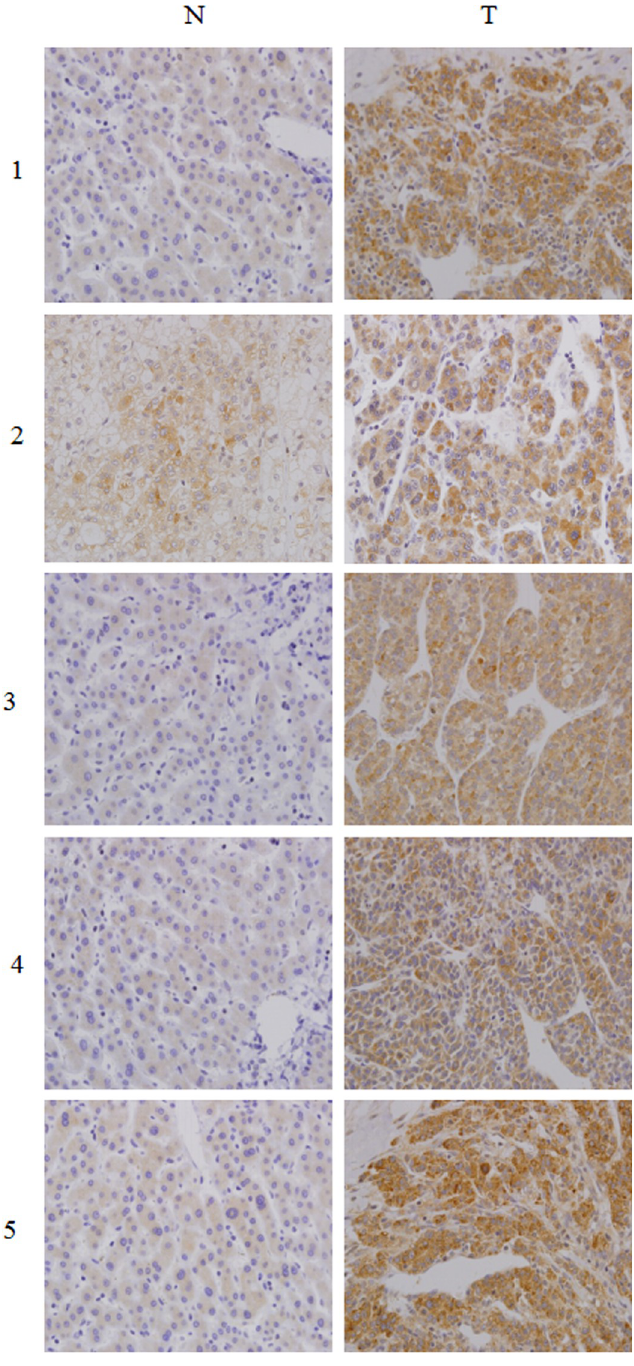
Fig 2. Numb expression level up-regulated in the primary HCC tissues compared with the paired adjacent non- cancerous tissues from the same patient, as examined by